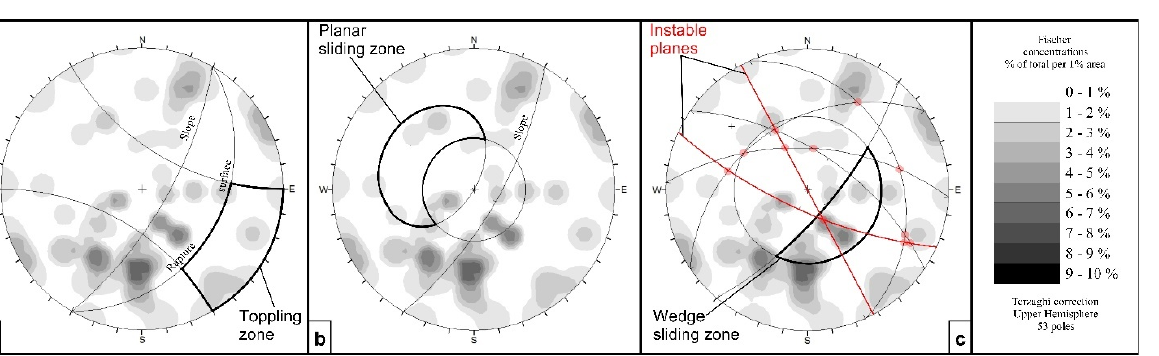
Figure 5. Result of the Goodman analysis conducted on the Bouanane cliff. ( a ) Toppling analysis, ( b ) Planar slide analysis. ( c ) Wedge slide analysis.